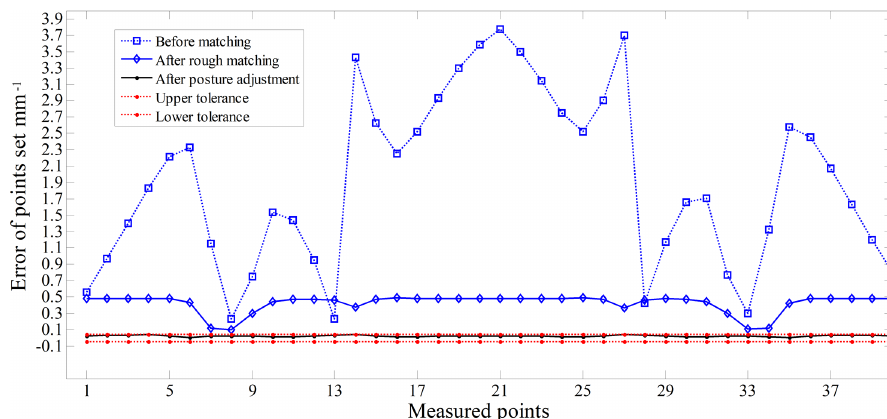
Figure 7. The errors of point set before and after posture adjustment by the SADE algorithm.